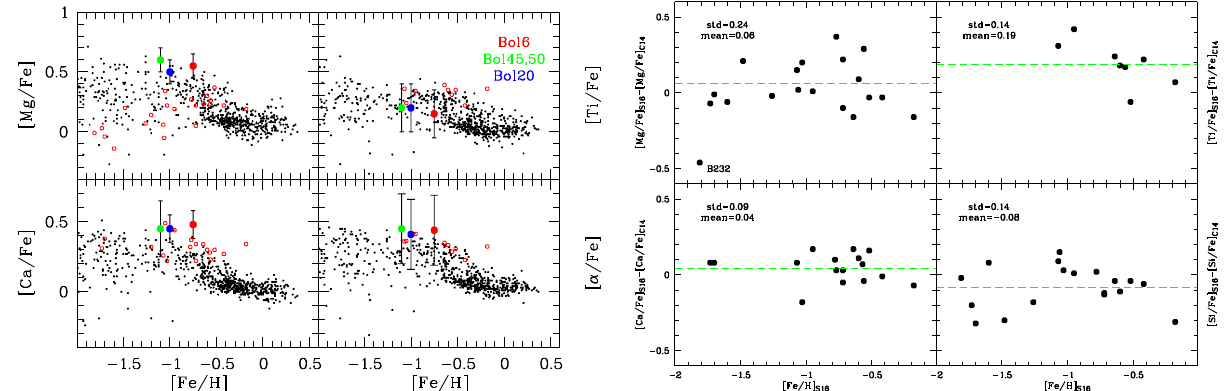
Figure 4: The same as in Figure 3, but the data for GCs in M31 were determined by S16.